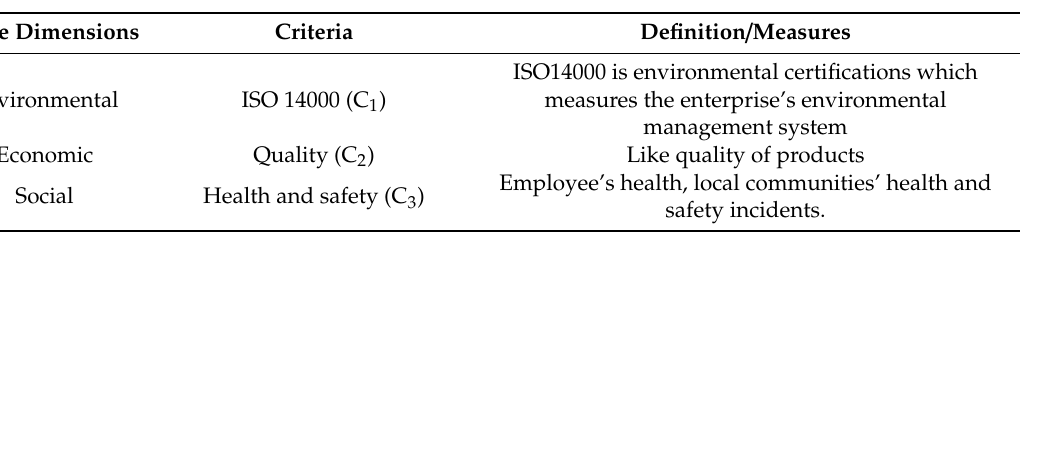
Table 1. Sustainable supplier selection